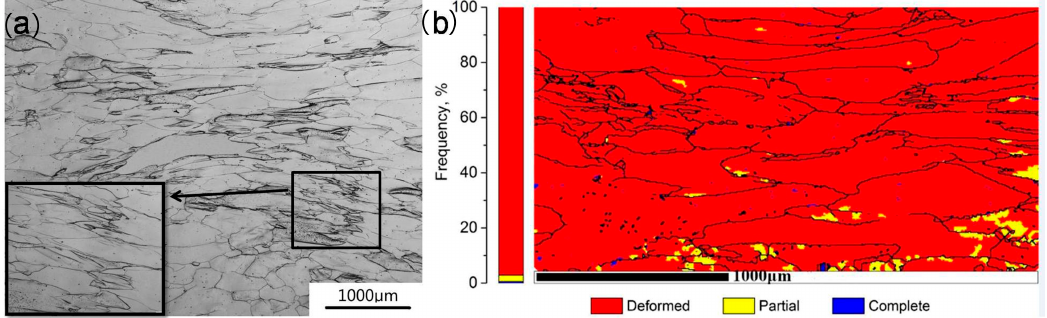
Figure 10. ( a ) microstructure; ( b ) recrystallized fractions of Domain 1 at the true strain of 0.7. Domain 2 indicates high power dissipation efficiency (0.4 < η < 0.55) and low instability ( ξ > 0),